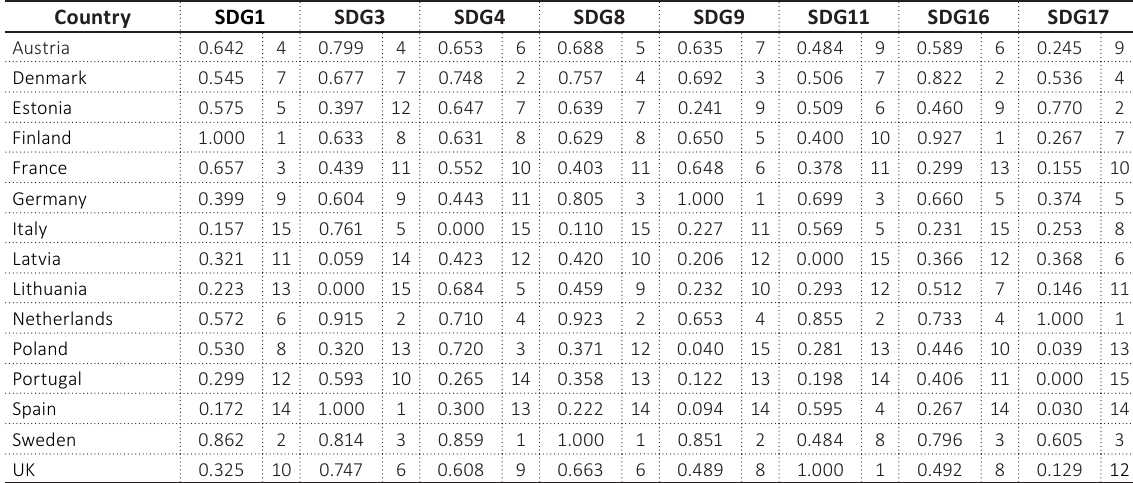
Source: Ziolo et al.